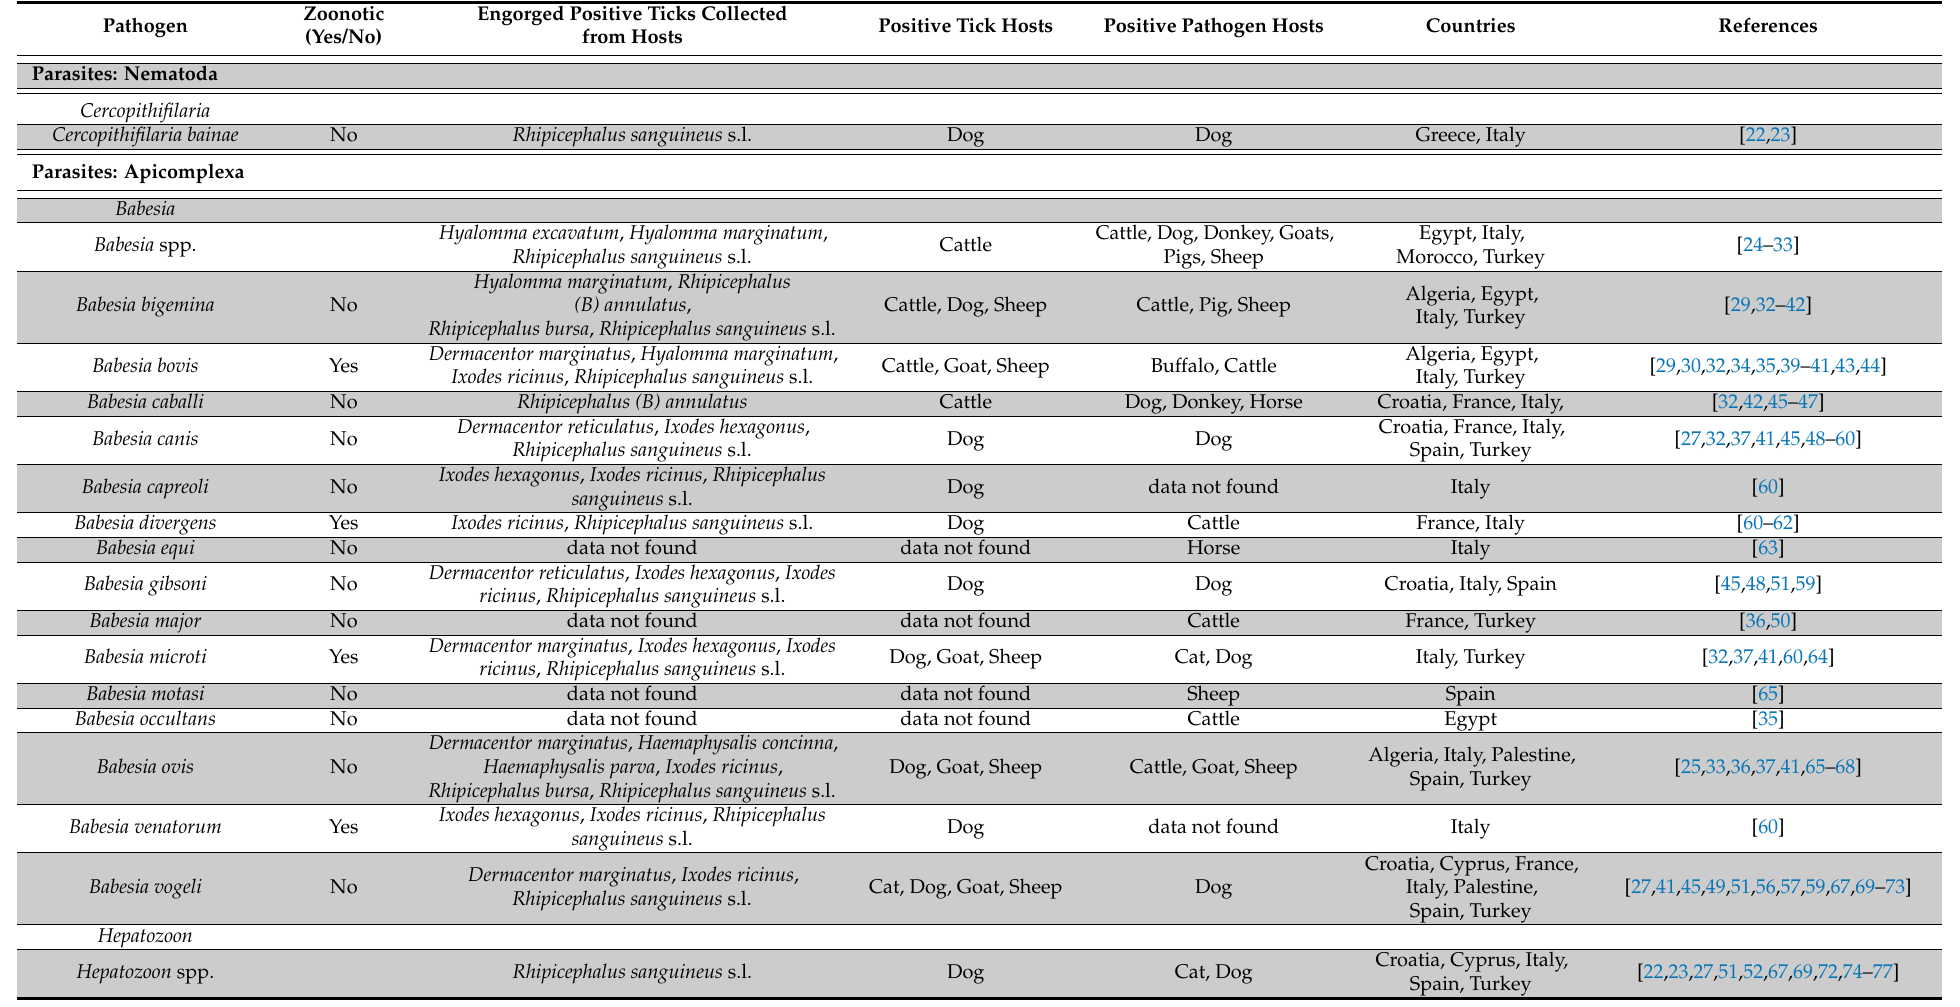
Table 1. Tick-borne pathogens detected in domestic animals or engorged ticks found on domestic animals in the Mediterranean